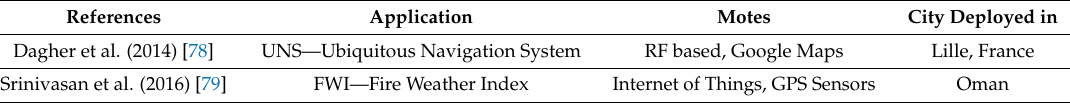
Table 11. Examples of prototyped applications for automated